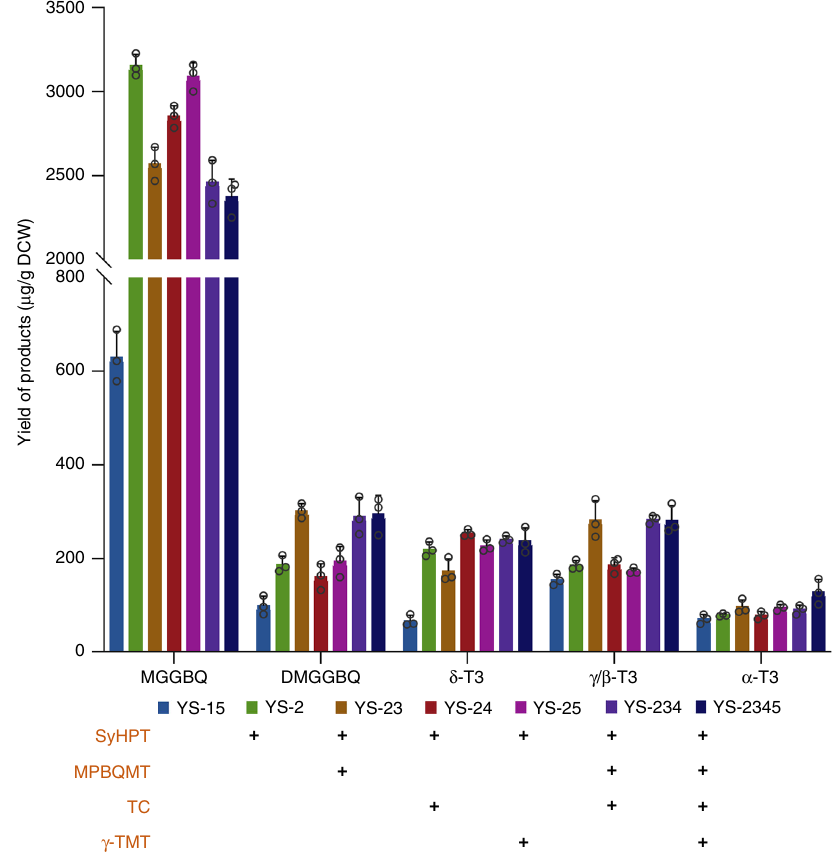
Fig. 2 Product pro fi les of the yeast strains overexpressing different enzyme combinations of the tocotrienols synthetic pathway. Columns of different colors represent different strains, and the horizontal axis shows different metabolites in the tocotrienols synthetic pathway. The enzymes overexpressed with an extra gene copy in each strain are indicated with ‘ + ’ . All values presented are the means of three biological replicates, and error bars represent standard deviations. Source data are provided as a Source Data fi